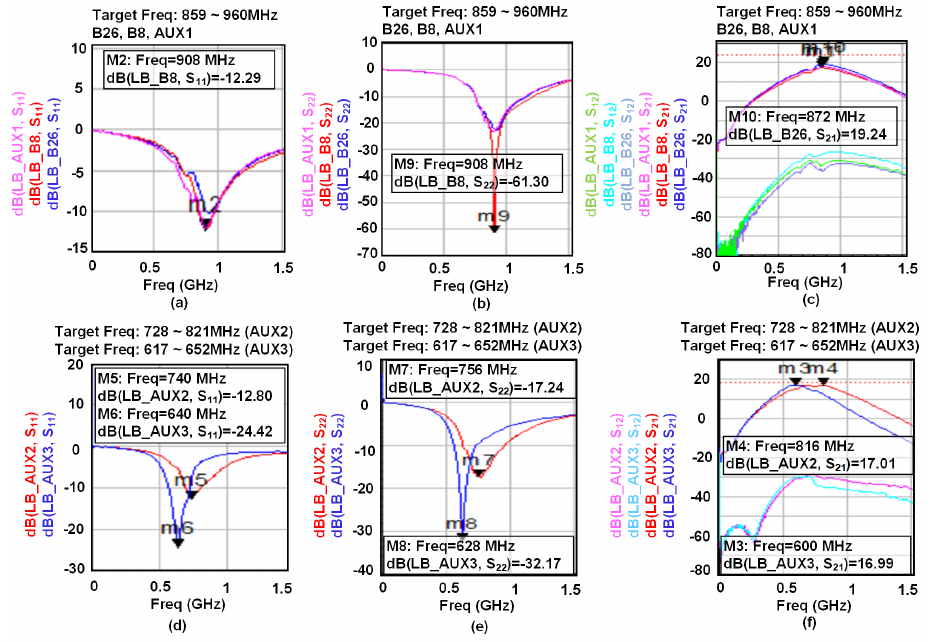
Figure 9. Measured S-parameter results: ( a ) S 11 , ( b ) S 22 , and ( c ) S 12 /S 21 for 859–960 MHz frequency ranges from B26, B8, and LB_AUX1 ports (Figure 1), ( d ) S 11 , ( e ) S 22 , and ( f ) S 12 /S 21 for 728–821 MHz and 617–652 MHz frequency ranges from LB_AUX2 and LB_AUX3 ports (Figure 1).